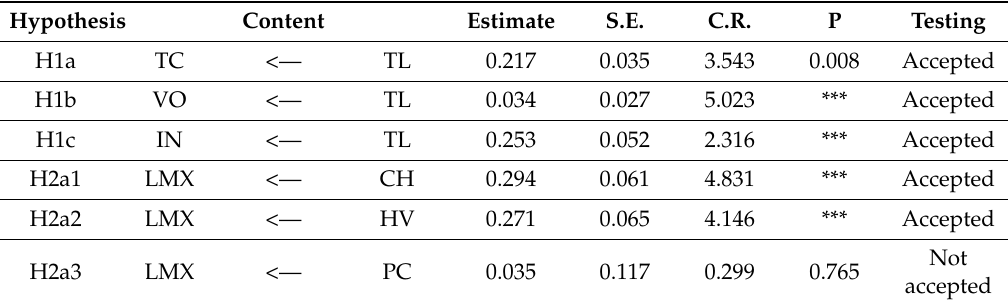
Table 3. Results of the verification of causal relationships between the model